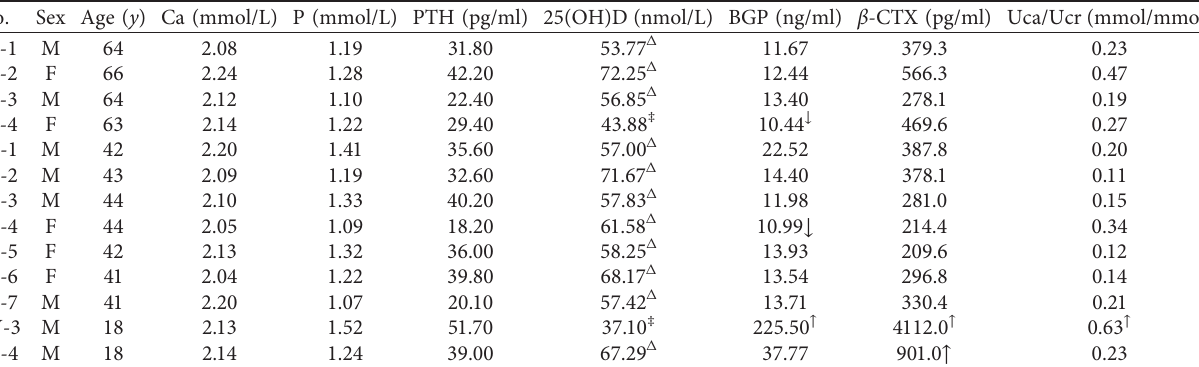
Table 1: Basic information and biomarkers for mineral and bone metabolism of all members in the twin family.